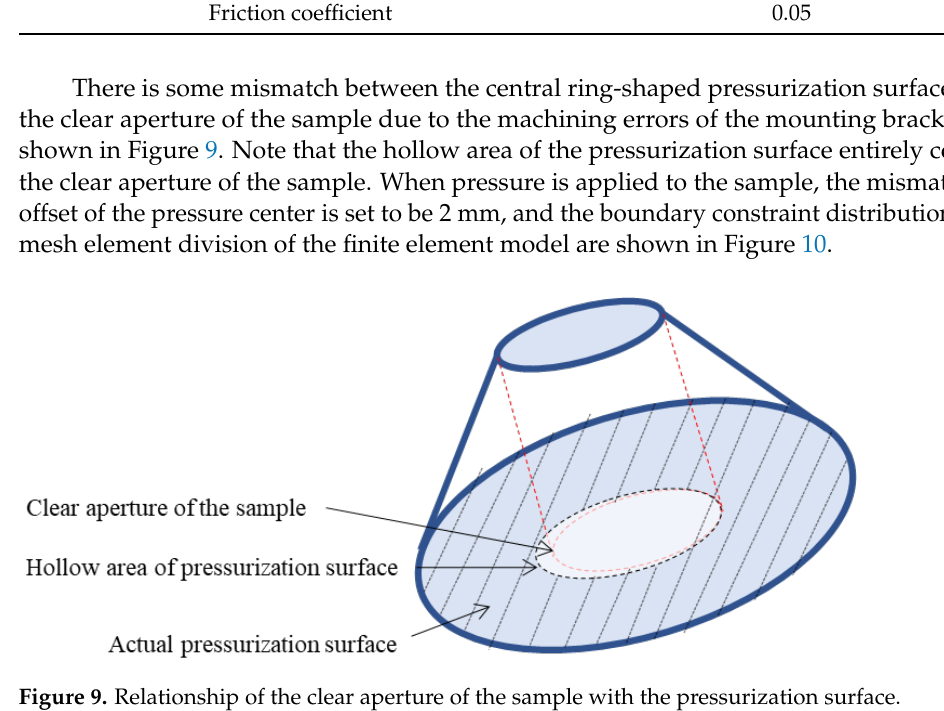
Figure 10. Boundary constraint and mesh division of finite element model. ( a ): boundary constraint image; ( b ): mesh division image.